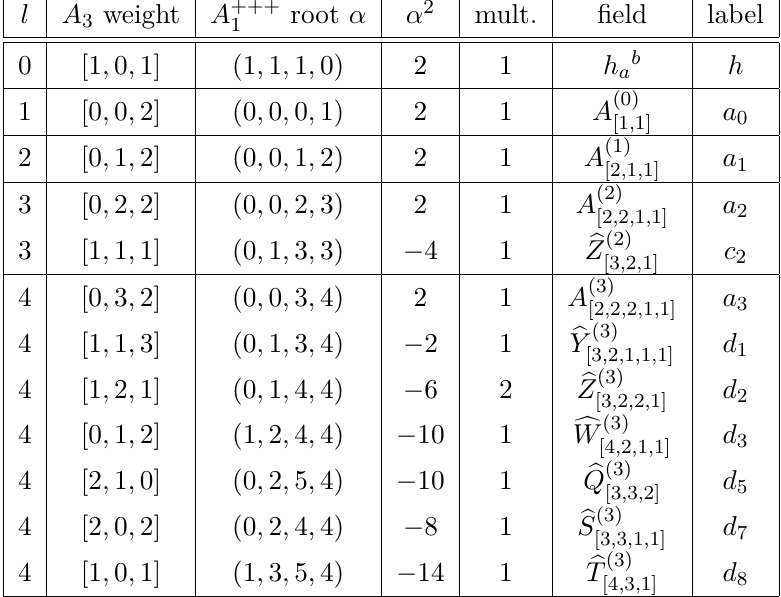
Table 1 . The adjoint representation of A +++